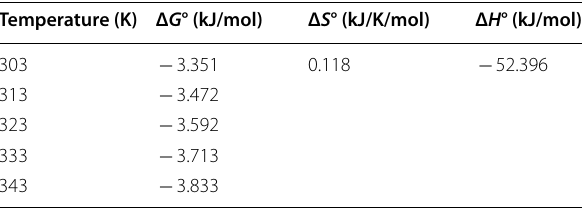
Table 4 Thermodynamic parameters for Cr (VI) bioreduction by Tamarindus indica methanol leaves extract at pH 2